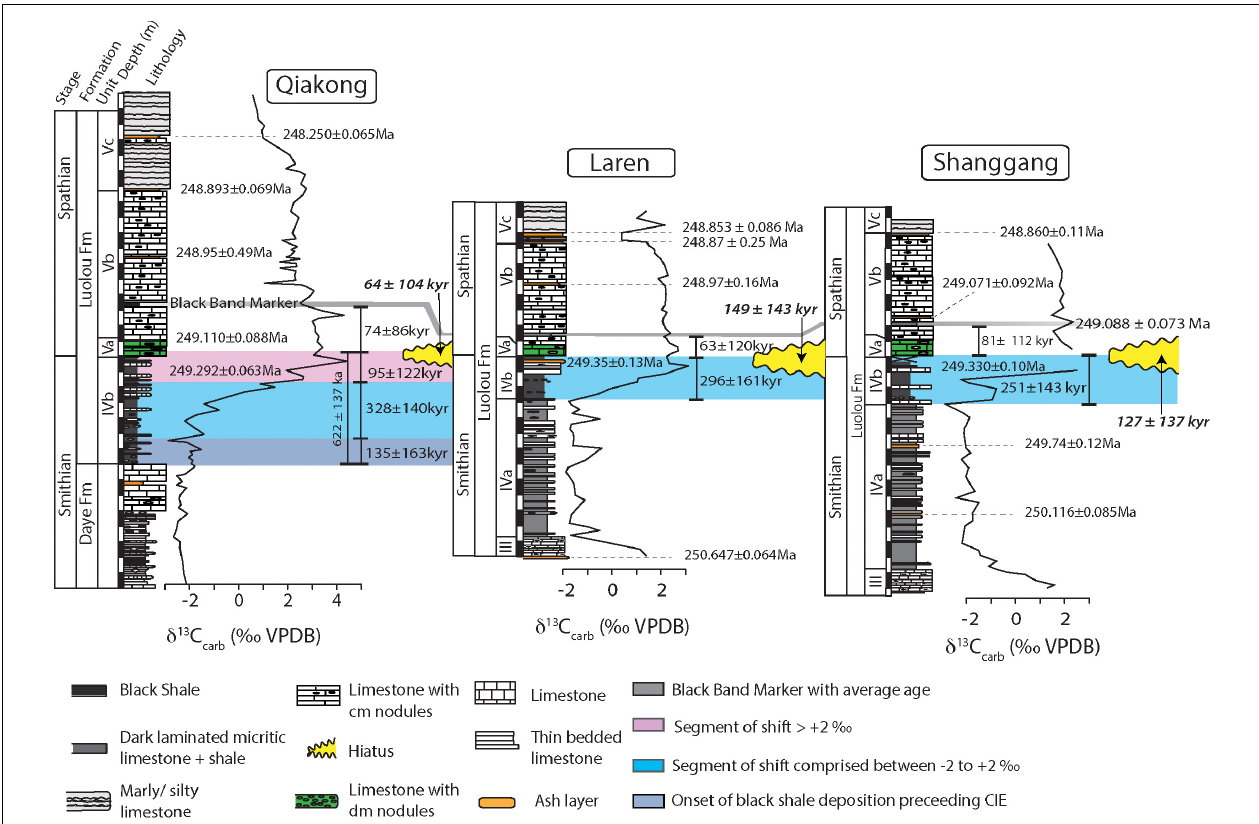
FIGURE 5 | Durations of the hiatus, of the carbon isotope excursion (CIE) and age of the early Spathian “Black Band marker.” Color code: pink represents the part of the CIE in the Qiakong section that is missing in Laren and Shanggang; blue: duration of preserved carbon excursion in Laren and Shanggang; white: duration between onset of nodular limestone and black shale marker; and purple: duration of pre-CIE black shale deposition in Qiakong. The Black Band Marker provides an independent isochronous time line. 206 Pb/ 238 U single-grain zircon ages of dated ash layers are indicated, for sample numbers see Figure 1